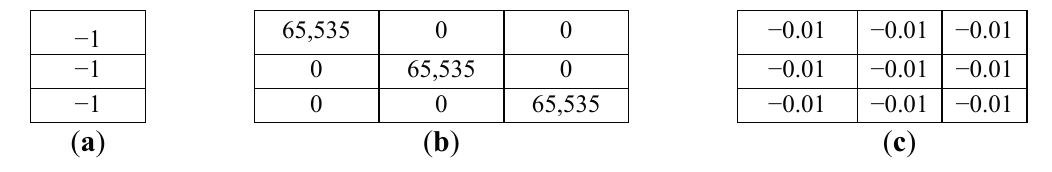
Figure 4. The calibration matrices with sample values. ( a ) Offset vector; ( b ) Sensitivity Matrix; ( c ) Alignment